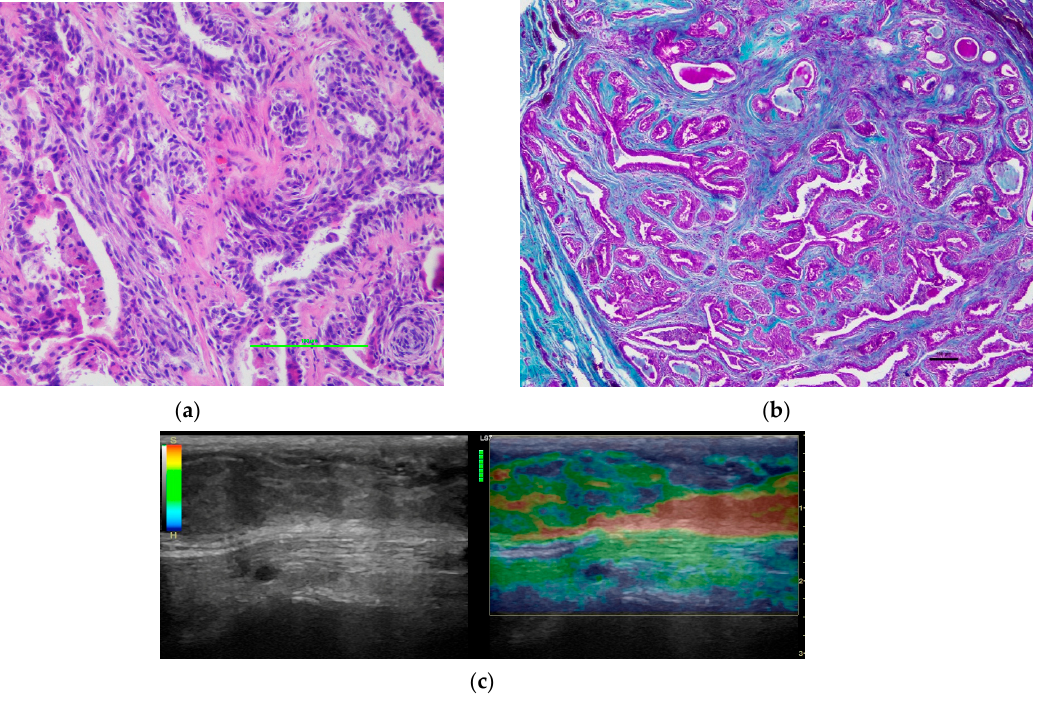
Figure 1. Representative image of a mass confirmed as a complex carcinoma. ( a ) Detail of the cellular composition of the tumoral tissue (H&E). ( b ) Histological detail of the tumor parenchyma of a complex carcinoma in which there was low presence of collagen fibers (Masson’s Trichrome). ( c ) B ‐ mode and elastographic images scored as 3 in the visual scale, corresponding to the same complex carcinoma sample.